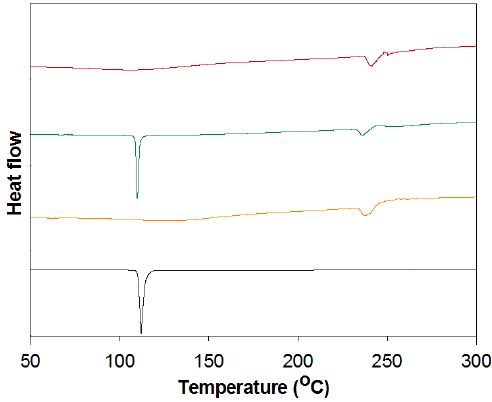
Figure 7 . DSC curves of FT (black), HP-β-CD-ol (orange), PM (green), and IC (red).